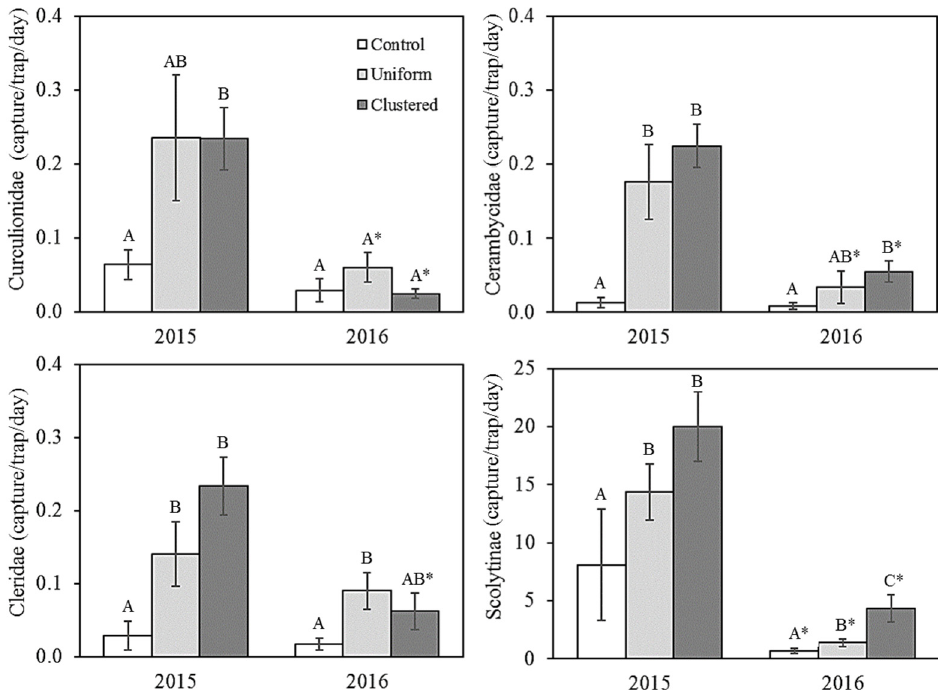
Figure 3. Mean capture ( ± SE) of Curculionidae, Cerambycidae, Cleridae, and Scolytinae per trap / day according to treatment and year. Di ff erent letters within a year indicate significantly di ff erent least-squares means among treatments, whereas asterisks represent significantly di ff erent least-squares means between years for the same treatment ( α = 0.05).